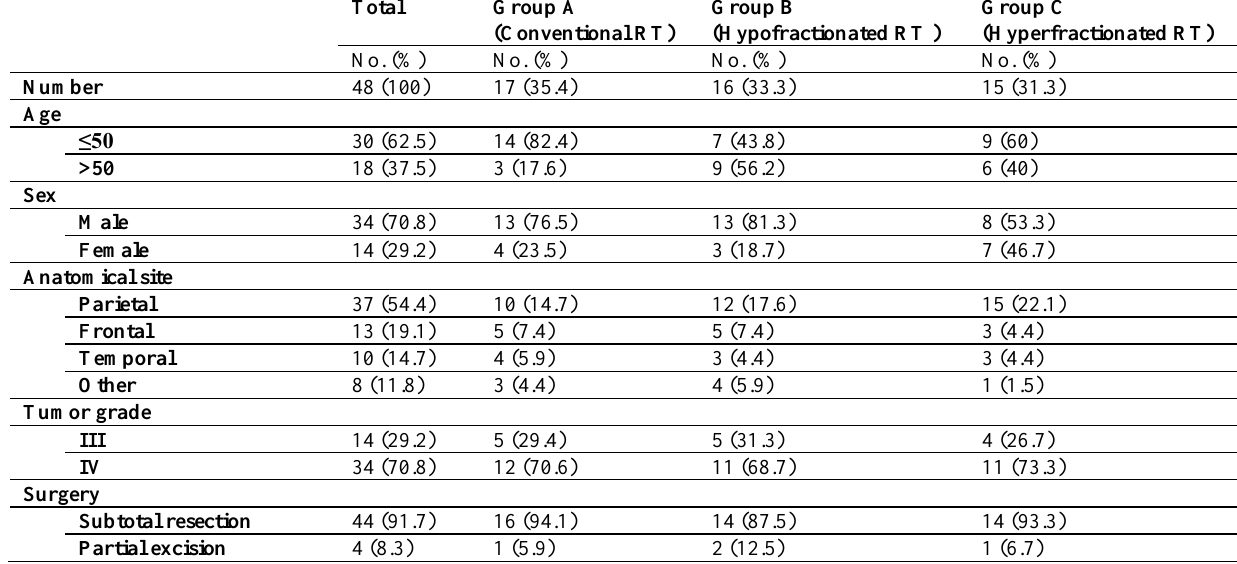
Table 1: Characteristics of patients